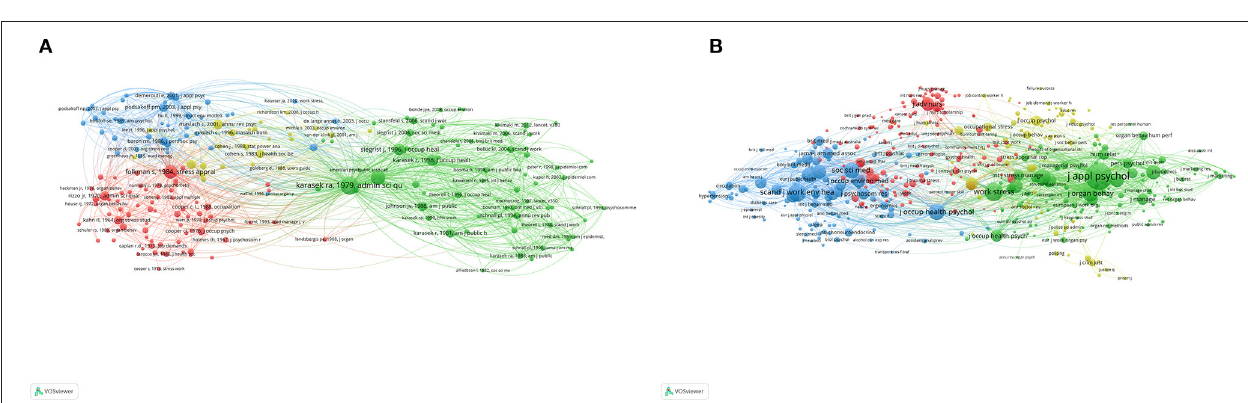
FIGURE 5 | Bibliometric analysis of co-citation. (A) Co-citation of the documents. (B) Co-citation of the sources. The size of the circles represents the counts of co-citations. The distance between the two circles indicates their